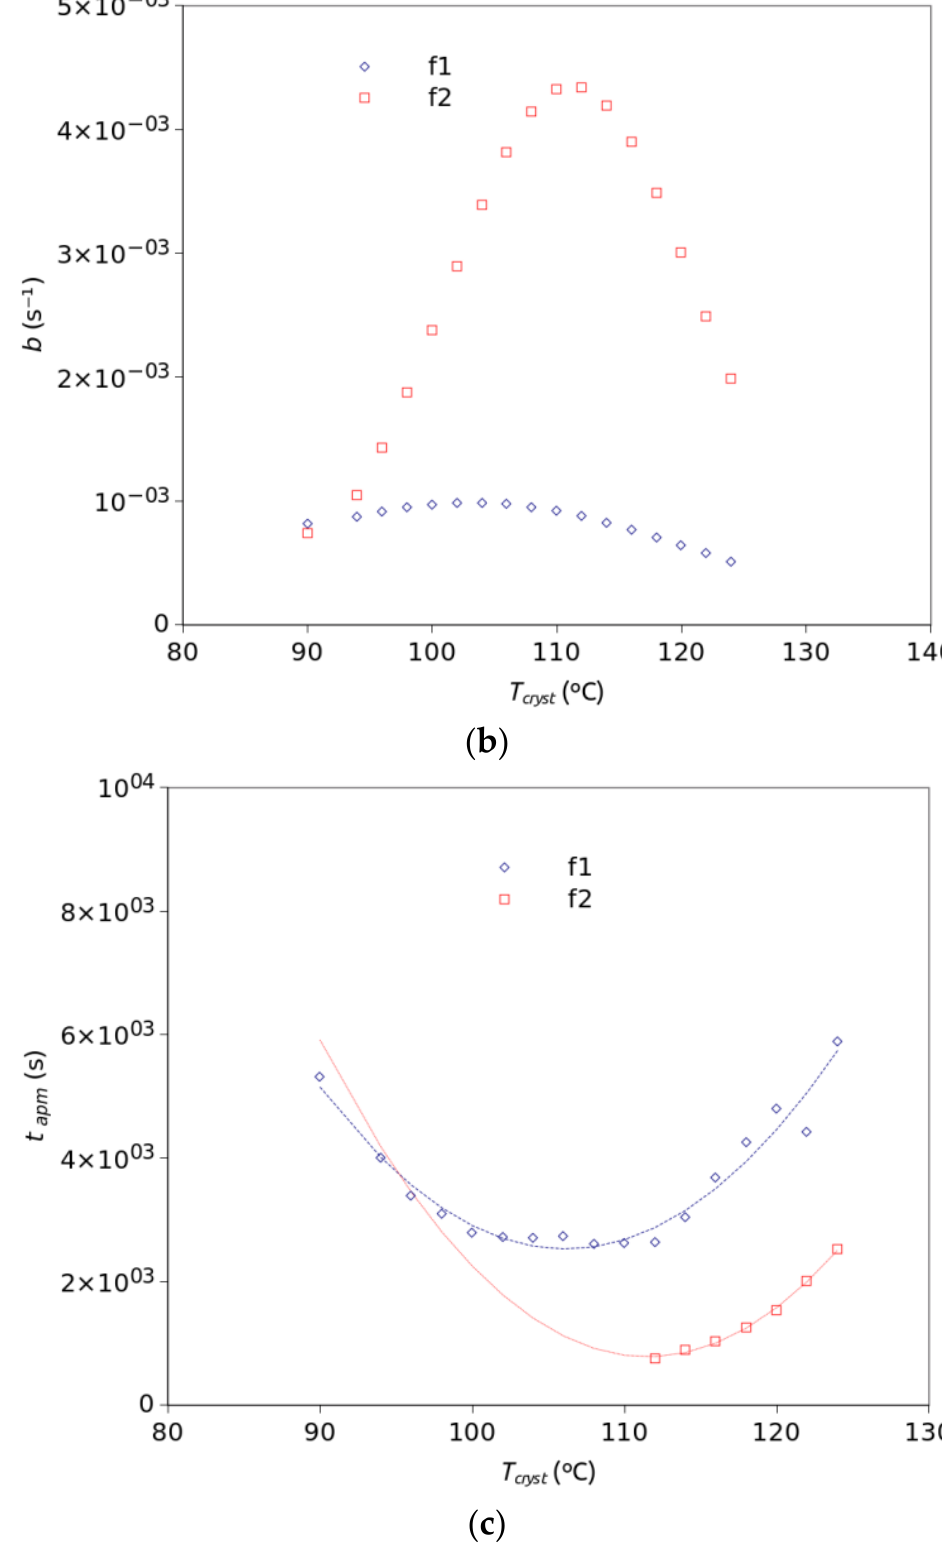
Figure 7. Temperature dependence of the fitting parameters: the c area factor ( a ), the b rate factor ( b ), and the t apm time at peak maximum, with over-imposed parabolic trend lines ( c ). Table 1. Number of functions used for each temperature and the ASE values obtained in each fitting.